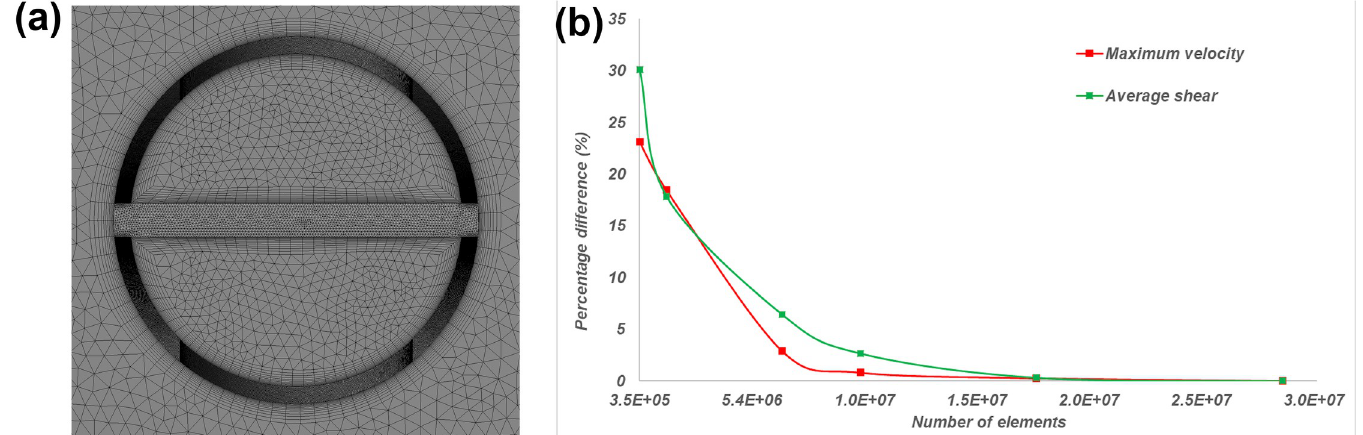
Fig 5. (a) Cross section of mesh, (b) Percentage difference with increasing elements for maximum tip velocity and average shear rate in tip.